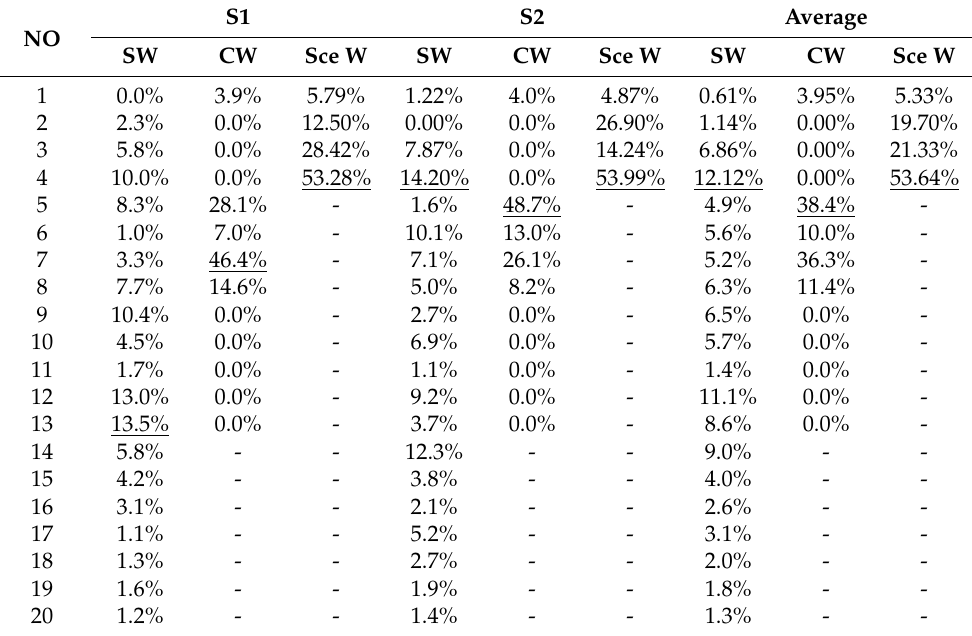
Table A1. Results of pairwise comparison of the Saaty scale (from − 9 to 9) for the national group.